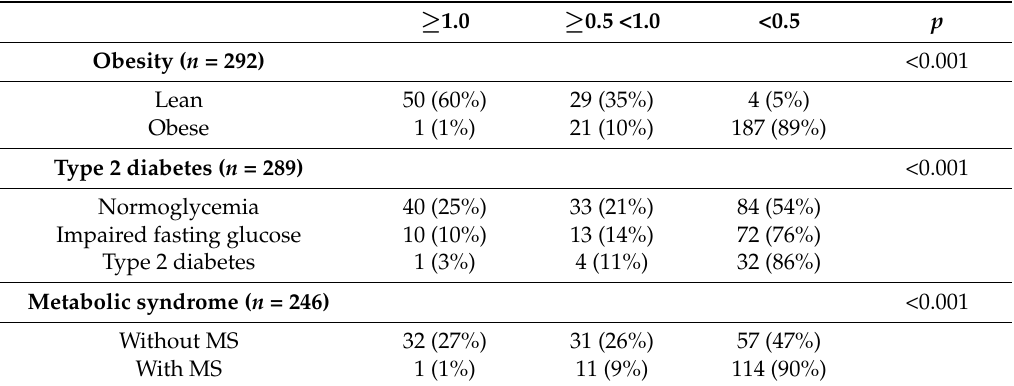
Table 2. Contingency tables of the individuals classified according to the Adpn/Lep ratio and metabolic